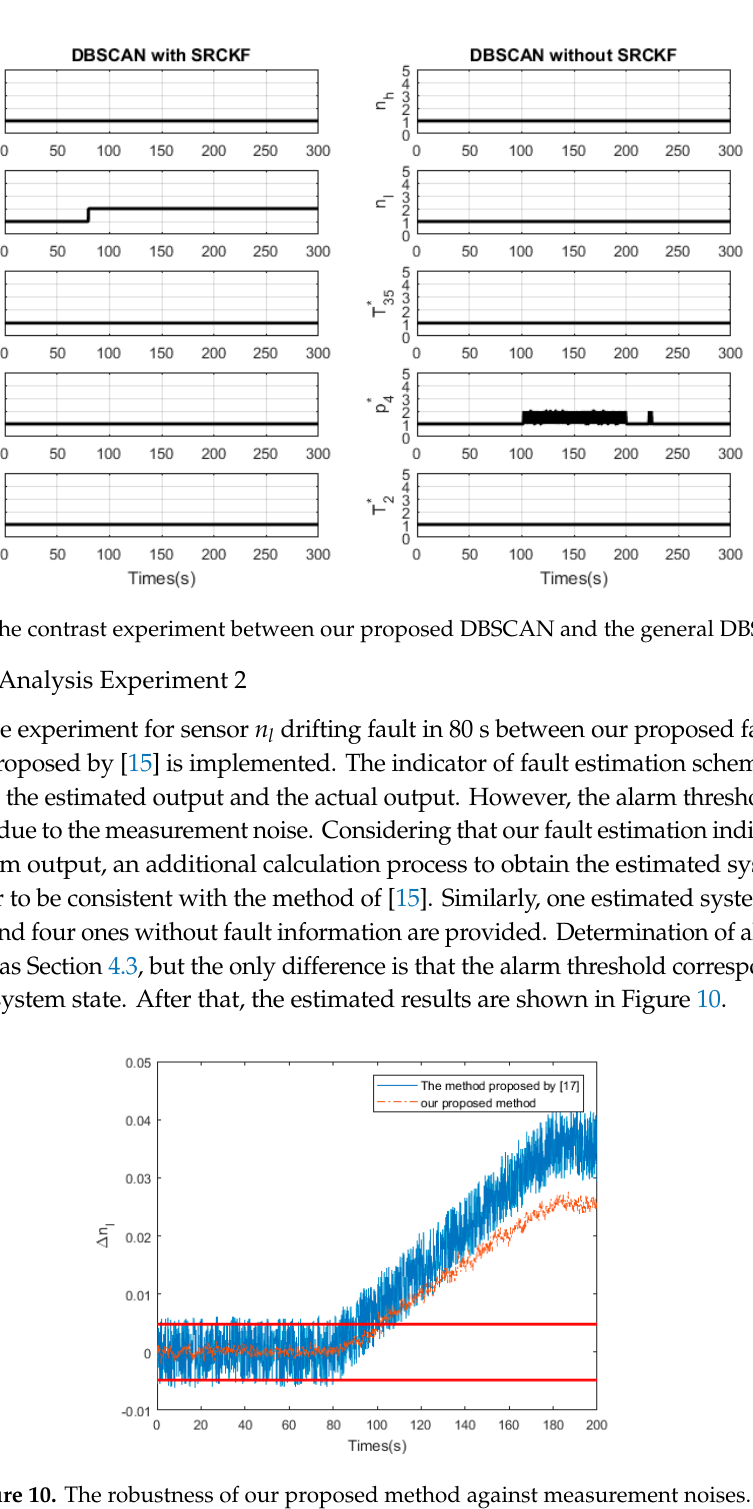
Figure 10. The robustness of our proposed method against measurement noises.